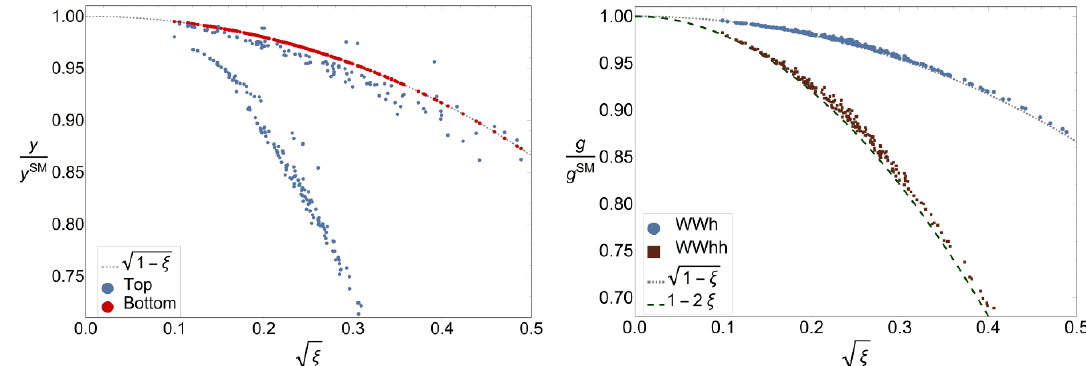
Figure 5 . On the left we show the Yukawa couplings of the top (in blue) and bottom (in red) quarks normalised to their SM values in the BP. The Yukawa coupling of the bottom quark was computed adding to the theory the Right-handed elementary bottom (cid:12)eld, assuming that this addition does not change noticeably the potential. On the right we show the couplings of the W boson with one and two Higgs bosons normalised to their SM values in the BP. The functions are plotted in gray dotted line and green dashed line